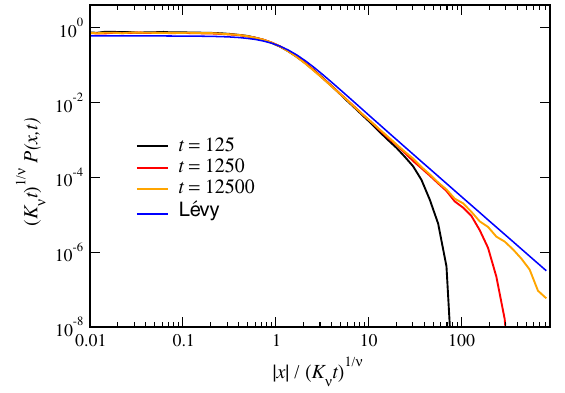
FIG. 7. ð K ν t Þ 1 = ν P ð x; t Þ versus x= ð K ν t Þ 1 = ν for ν ¼ 7 = 6 ( D ¼ 2 = 5 ). The Lévy PDF, Eq. (78), with K ν , Eq. (76), perfectly matches simulations without fitting. Notice the cutoff for large x , which is due to the coupling between jump lengths and waiting times, making x > t 3 = 2 unphysical.